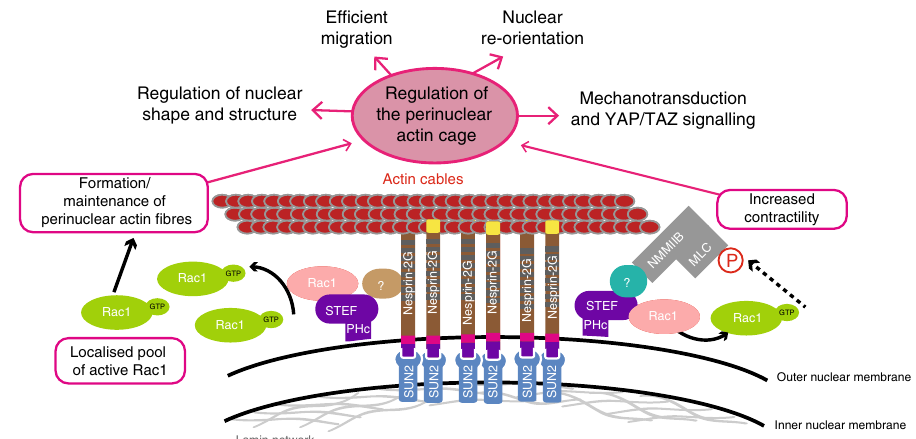
Fig. 7 Model describing the role of perinuclear STEF. STEF at the nuclear envelope generates a localised pool of active Rac1 which is required for the formation and/or stabilisation of perinuclear actin cables and for perinuclear actomyosin contractility. Disruption of the perinuclear actin cap in STEF- depleted cells alters the structural and morphological properties of the nucleus, with consequences for directed cell migration